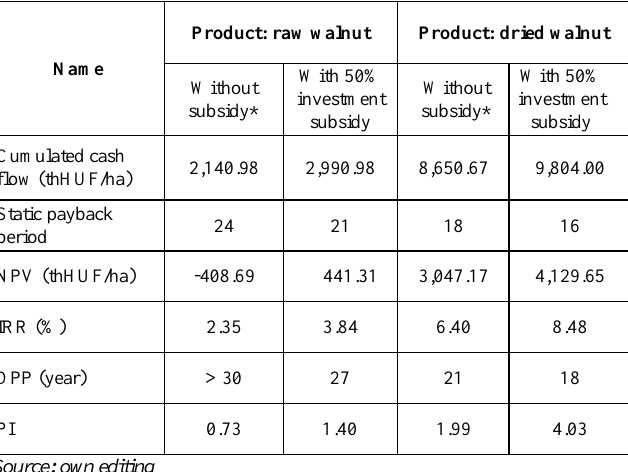
Table 11. Investment profitability indicators in the two examined versions with and without 50% investment subsidy